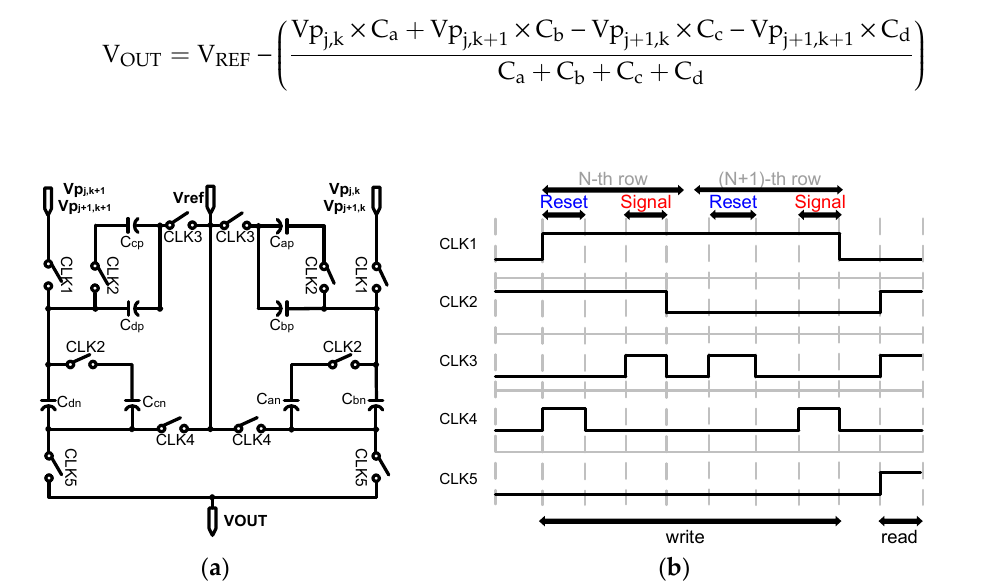
Figure 5. ( a ) Analog convolution circuit using a switched capacitor and ( b ) timing